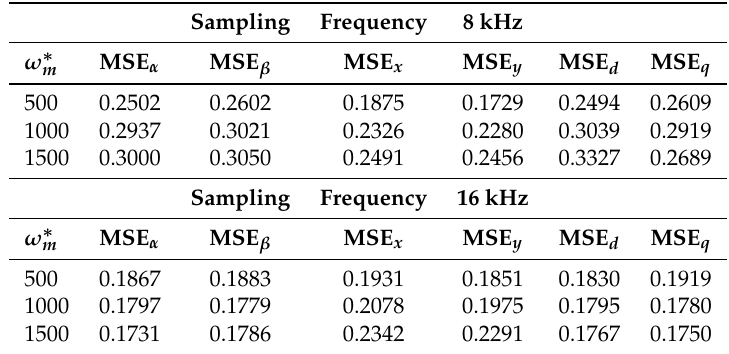
Table 2. Performance analysis of stator currents α − β , x − y , d − q and MSE (A) for three different rotor speeds